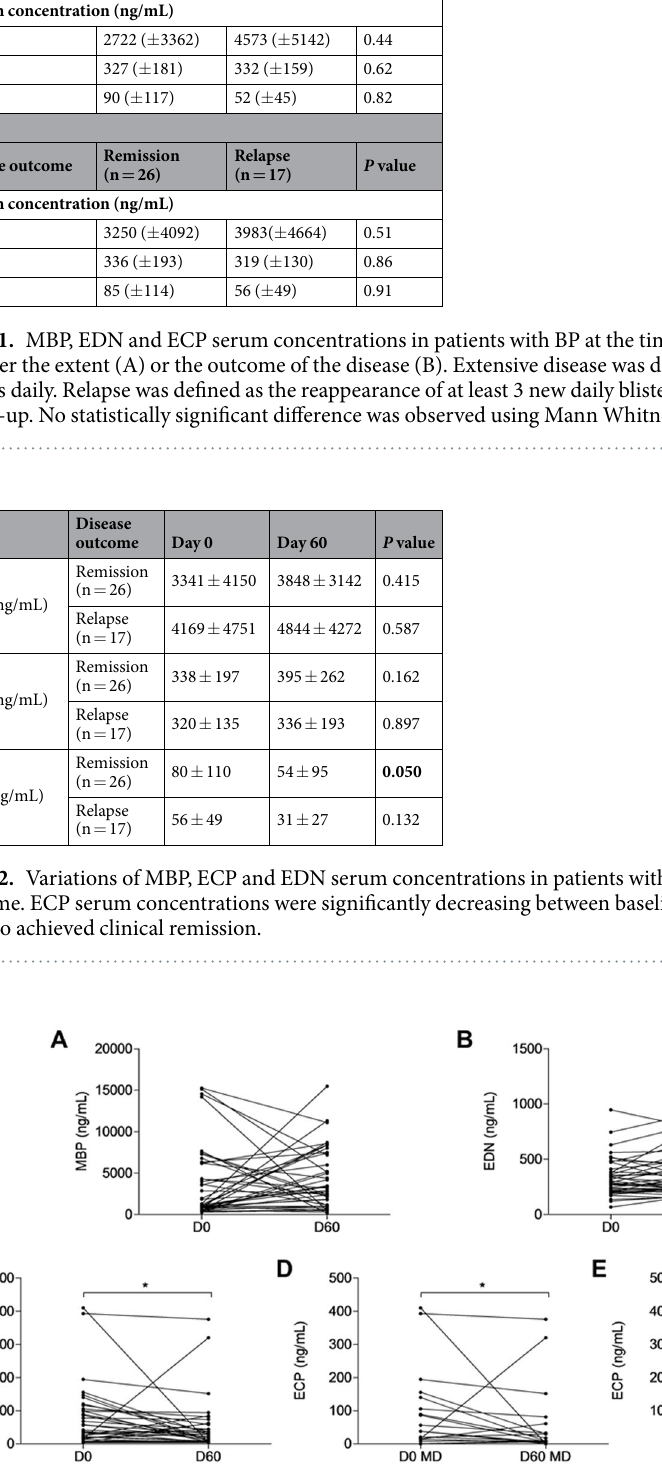
Figure 2. MBP, EDN and ECP serum variations between baseline and day 60. Variations in the serum concentrations of MBP ( A ), EDN ( B ) and ECP ( C ) were measured by mean of specific ELISAs between days 0 and 60. (MD: Mild disease; R0: Remission). ( * P < 0.05).